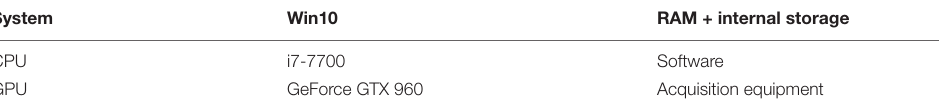
TABLE 2 | The experimental environment.